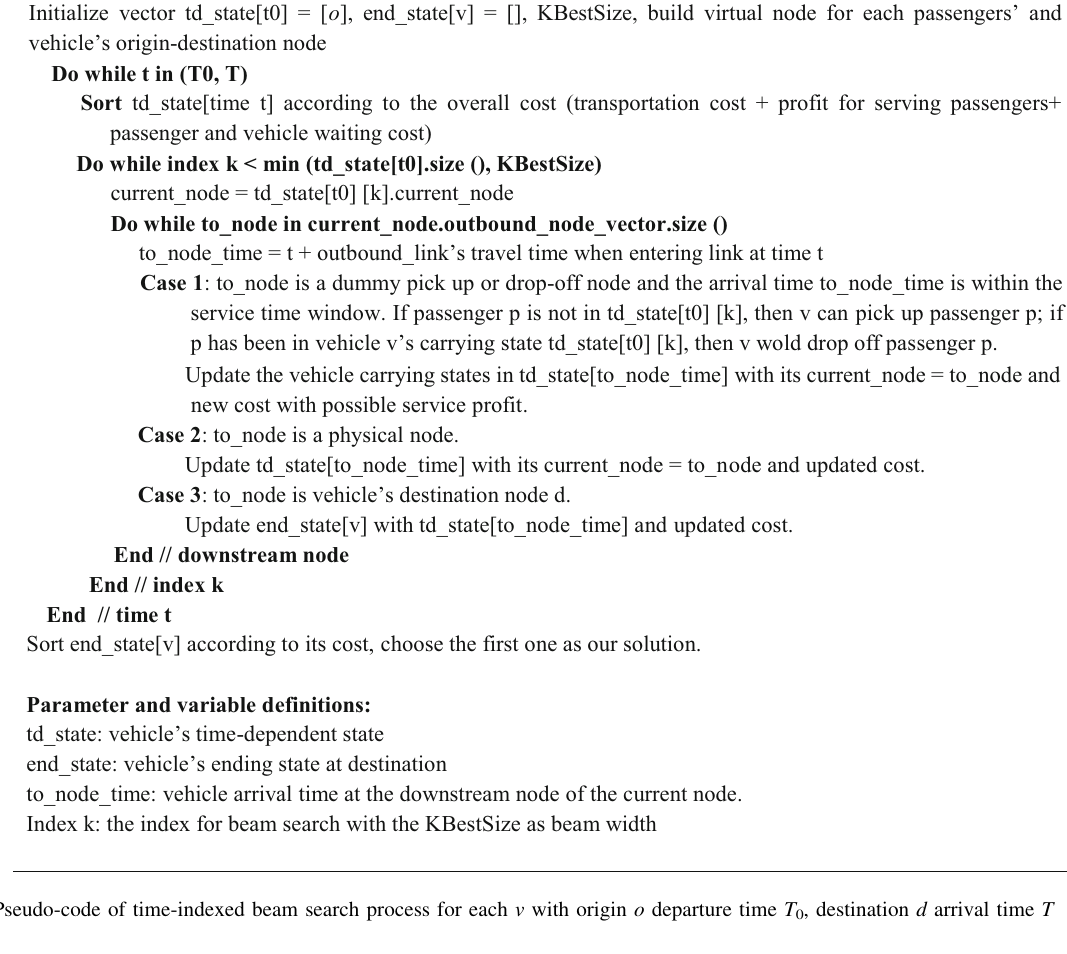
Fig. 4 Pseudo-code of time-indexed beam search process for each v with origin o departure time T 0 , destination d arrival time T